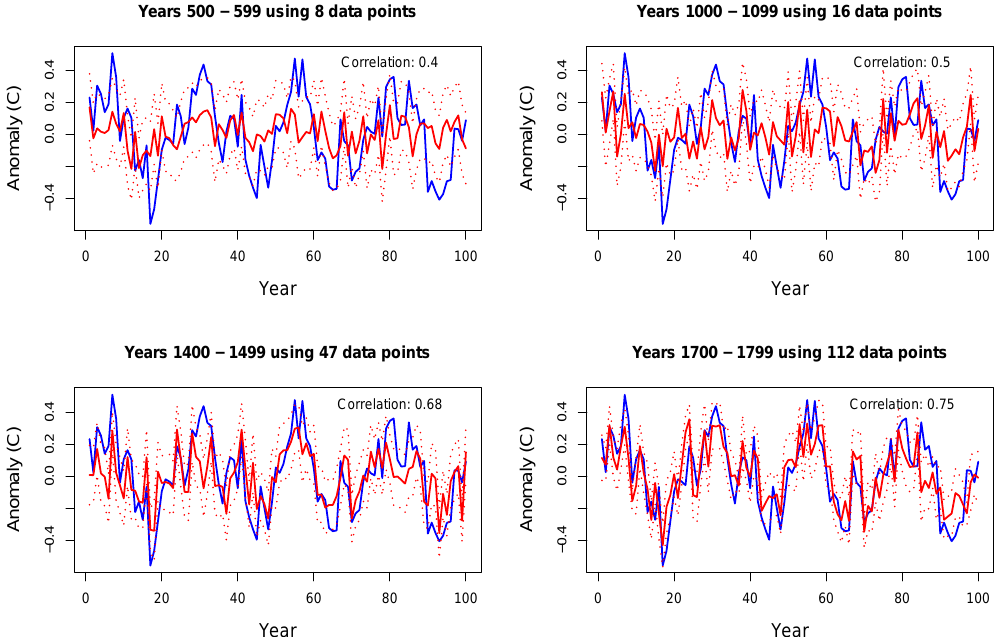
Fig. 5. Reconstruction of NH annual mean temperature anomaly for the case of externally forced changes, based on different number of proxy data points. Blue lines indicate target (identical in each panel). Solid red line indicates reconstruction, with dotted lines showing the ± 1 standard deviation uncertainty. Correlations are averages over multiple experiments for each